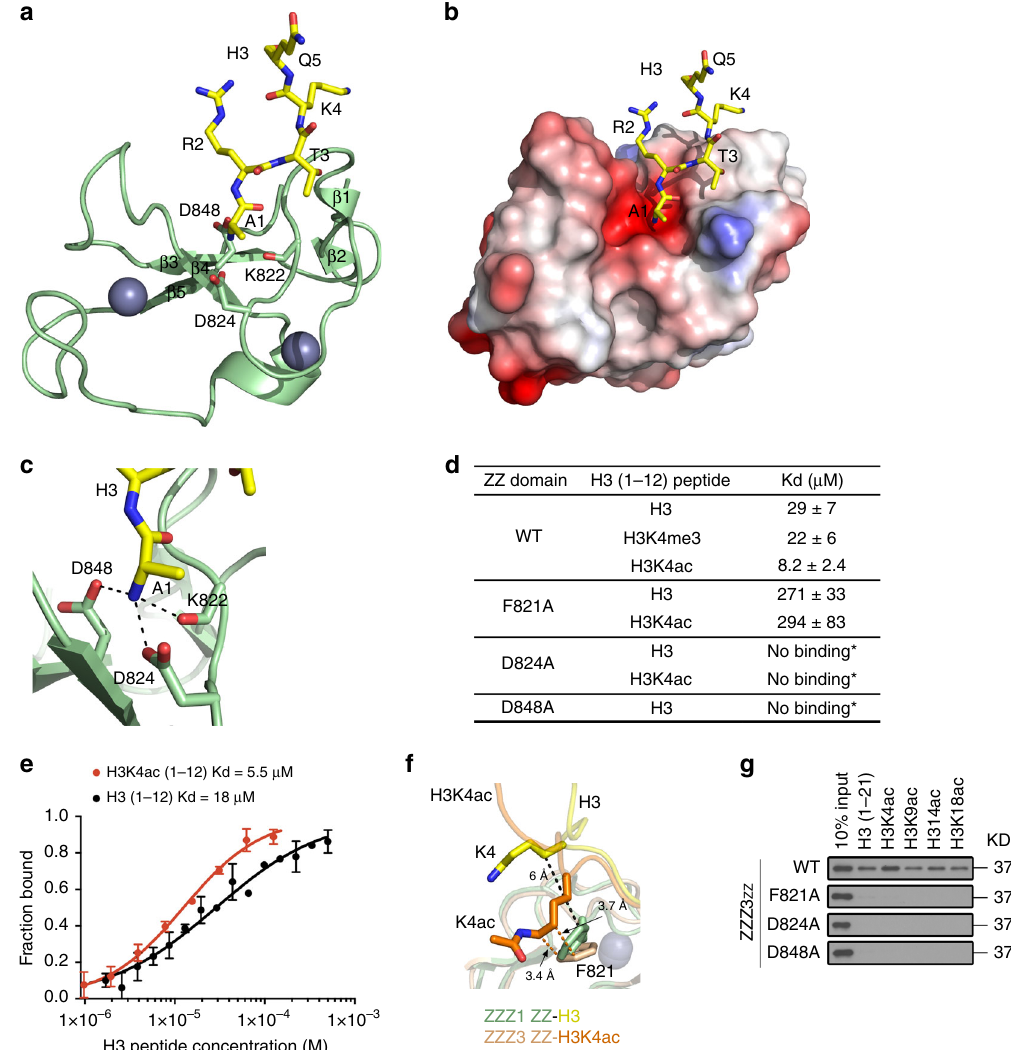
Fig. 2 Structure of the ZZZ3 ZZ domain in complex with H3 peptides. a Ribbon diagram of the ZZZ3 ZZ 816 – 874 domain (green) in complex with the histone H3 peptide (yellow). b Electrostatic potential surface of ZZZ3 ZZ in complex with the histone H3 peptide (yellow stick). A positive electrostatic potential is colored in blue and negative in red. c Zoom-in view of the histone H3 Ala1 binding site. ZZZ3 ZZ domain is shown as a green ribbon and the histone H3 peptide as a yellow stick. The dash lines indicate short distances. d Binding af fi nities of WT ZZZ3 ZZ and mutants for the indicated histone peptides measured by tryptophan fl uorescence. The experiments were carried out in triplicates. *: measured by NMR. e Binding curves used to determine the K d values by MST. f Zoom-in view of the mean position of Lys4 in each ensemble of 20 NMR structures of the complexes of ZZZ3 ZZ with unmodi fi ed H3 peptide and with H3K4ac peptide are superimposed. g Western blot analysis of histone peptide pulldowns of wild-type (WT) ZZZ3 ZZ and the